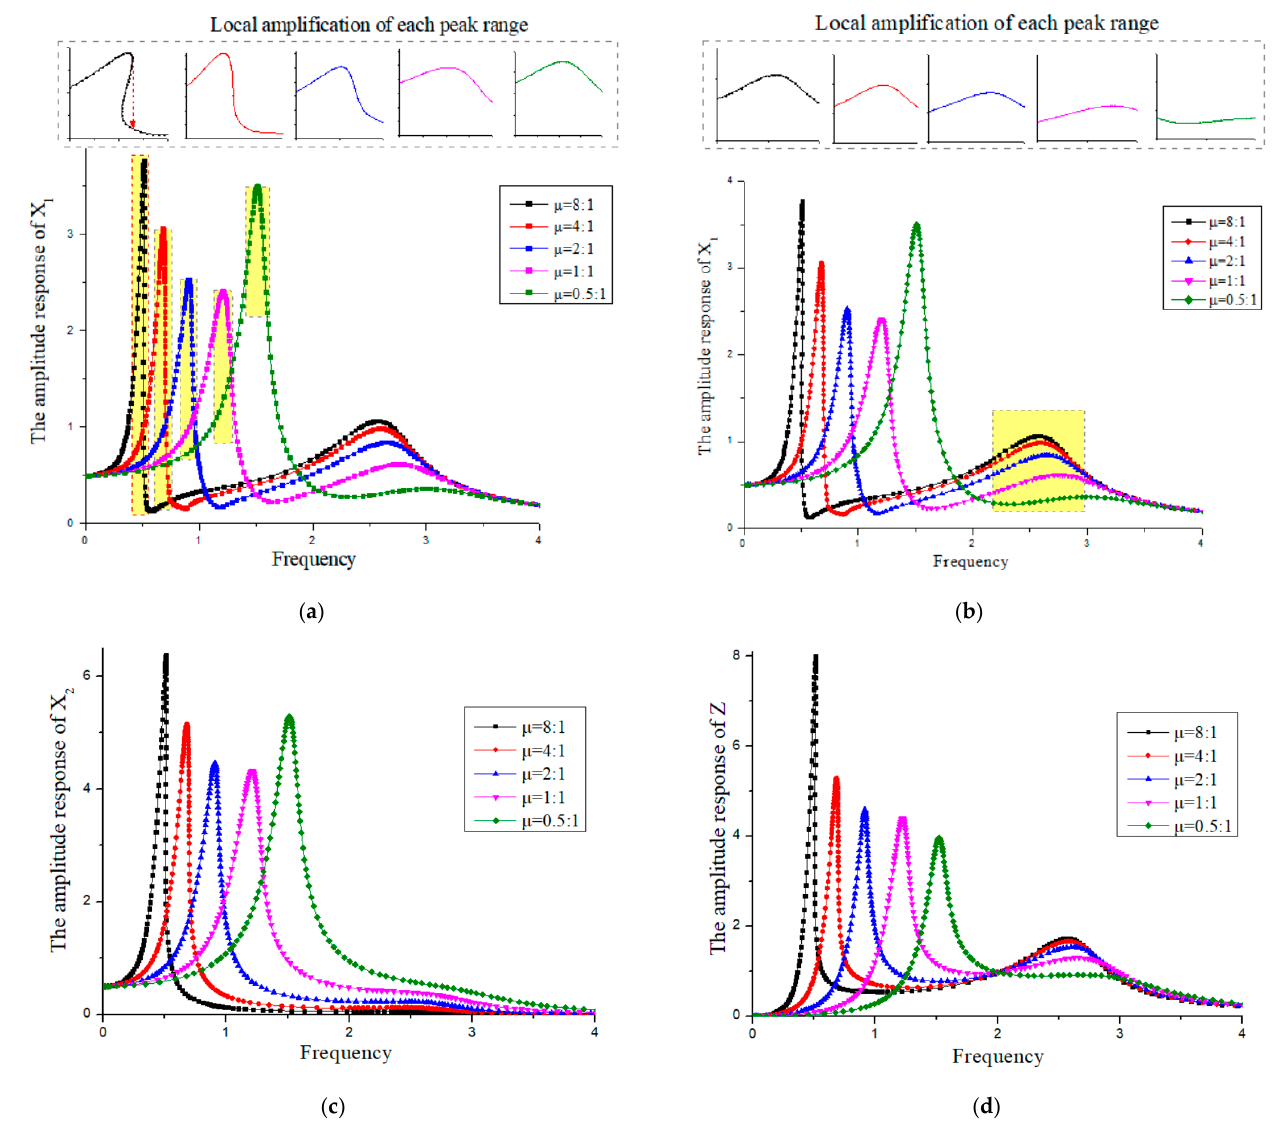
Figure 8. Amplitude–frequency characteristic curves of the isolation structures with different mass ratios ( a , b ) Amplitude–frequency characteristic curve of the substructure; ( c ) Amplitude–frequency characteristic curve of the superstructure; ( d ) Amplitude–frequency characteristic curve of the hysteretic element.